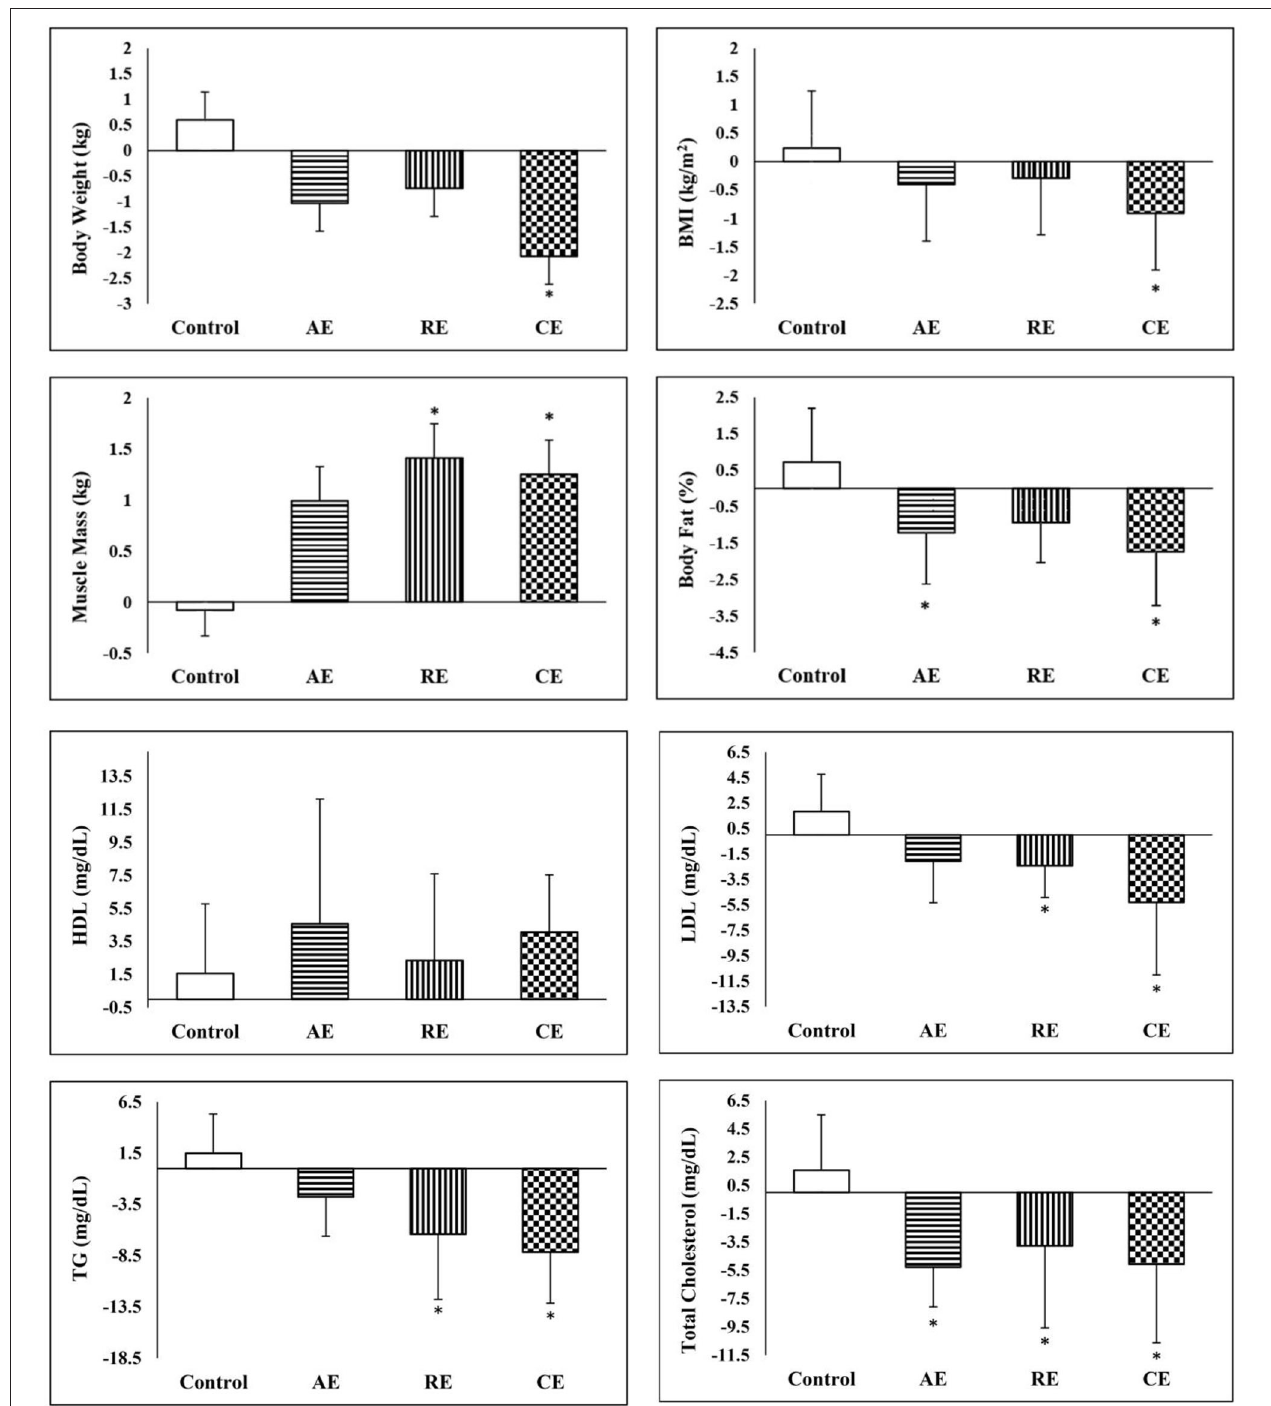
FIGURE 3 | Comparison of changes in anthropometric and lipid profile between the groups. *Significant difference in comparison with the control group ( p < 0.05). AE, aerobic exercise; RE, resistant exercise; CE, combined exercise.